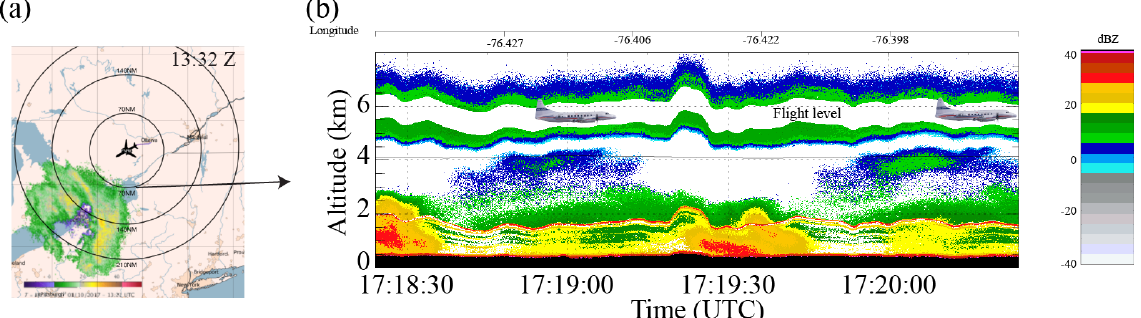
Figure 8. (a) Screen capture of NexRad Buffalo S-band radar received at the aircraft as it leaves Ottawa, ON, Canada on 10 January 2017. (b) Vertical cross section of reflectivity obtained by the NRC airborne X-band (NAX) radar while the aircraft is sampling a cloud system over Lake Ontario.